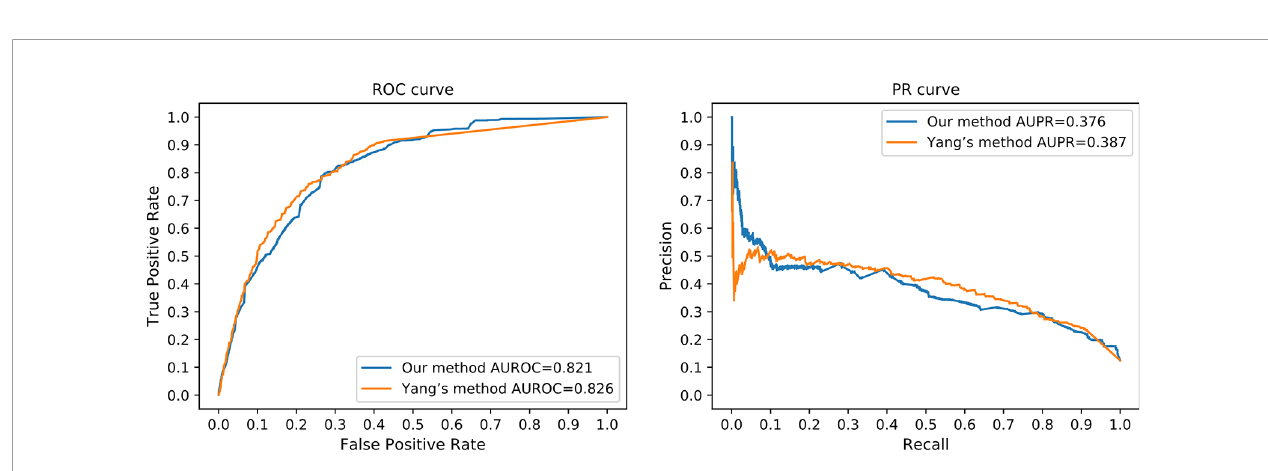
FIGURE 6 | ROC curve and PR curves of single similarity matrix. Since we only use similarity matrix for lncRNAs or proteins, not the same time, we only have six different curves in each panel. The axis in both panels have the same meaning as in Figure 5 , respectively. The “ Net, ” “ Seq, ” and “ Feat ” have the same meaning as the legends of Figure 5 .